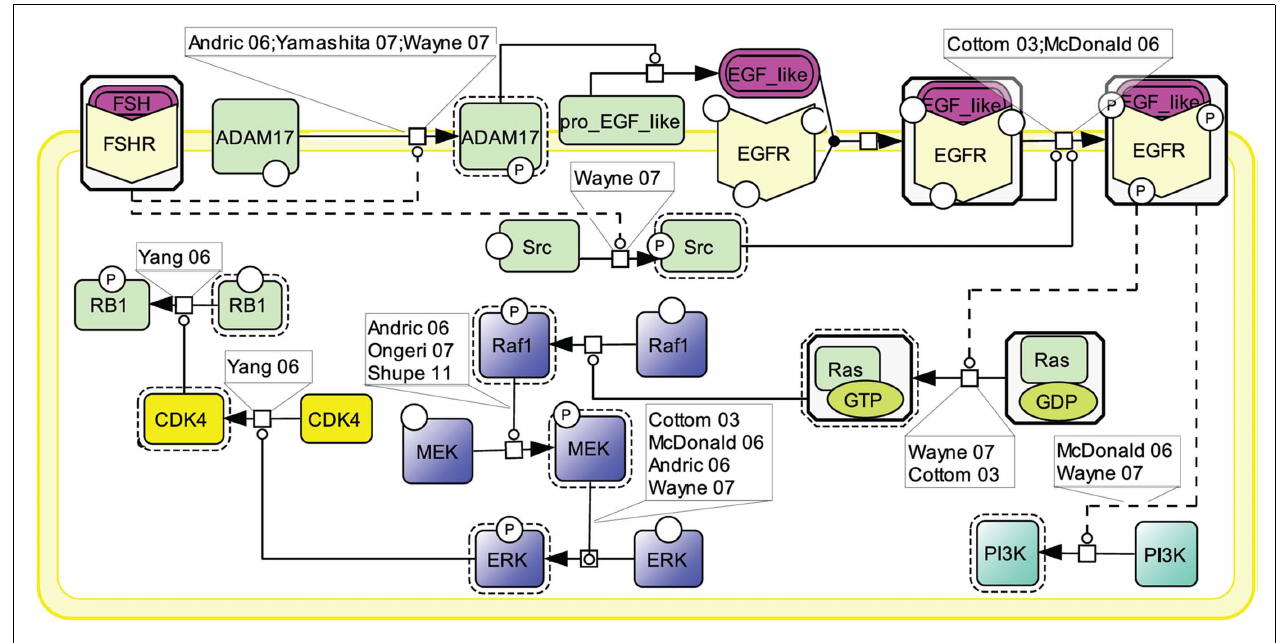
which subsequently binds to and activates EGFR; second, FSH activates Src which directly phosphorylates EGFR, thereby eliciting EGF-independent activation of this receptor. MAPK ERK and PI3K pathways have been shown to be activated as a result of EGFR transactivation by